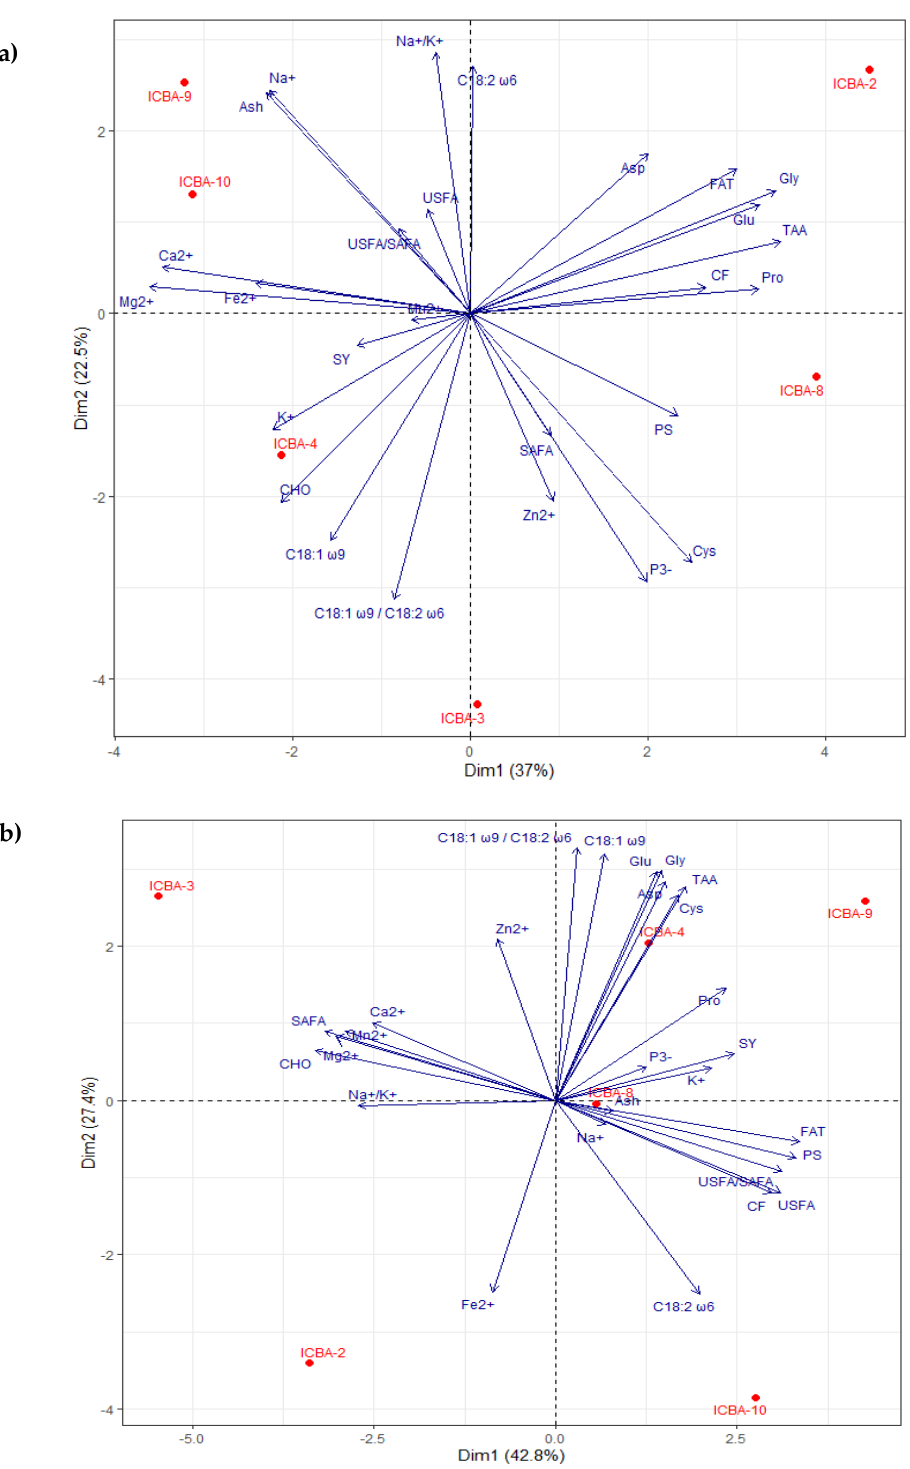
Figure 5. Plot of Principal Component Analysis (PCA) for seed yield, proximate composition, micronutrients, amino acids and fatty acids for six S. bigelovii genotypes at: ( a ) ICBA and ( b ) Mubarak Valley for the first two dimensions See Table A8 for eigenvector values of each parameter for PCA dimension 1 (Dim1) and 2 (Dim2).